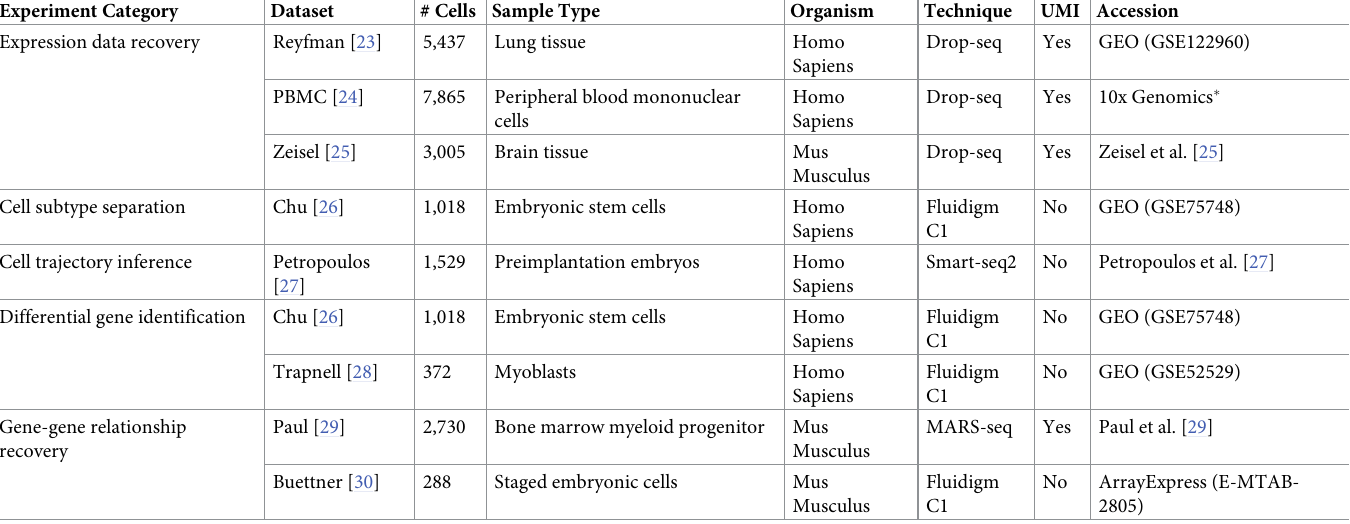
Table 1. Detailed information on the eight scRNA-seq datasets used to compare the performance of imputation methods. Experiment